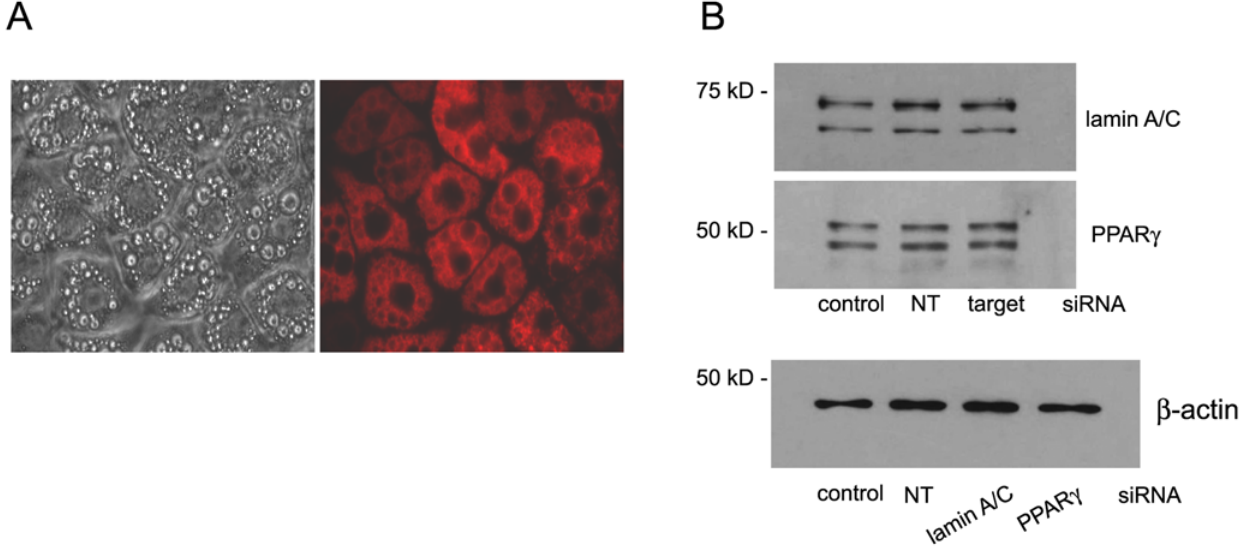
Figure 6. Transfection of adherent 3T3-L1 adipocytes with siRNA does not decrease expression of targeted proteins. Forty-eight hours post-transfection, transfection efficiency was assayed as uptake of fluorescent-labeled siRNA and the siRNA-mediated effect on targeted protein expression. (A) Brightfield and fluorescent (rhodamine filter) images of the transfected cells were taken with a 40X objective. (B) Knockdown of lamin A/C and PPAR c was assayed via western blot analysis post-transfection with either the RISC-free control siRNA (control), nontargeting siRNA (NT), or siRNA targeted to the indicated gene (target). Thirty-five m g of protein was loaded in each lane and separated by SDS-PAGE. Equal loading of each lane was determined using b -actin expression. The experiment was carried out twice independently.